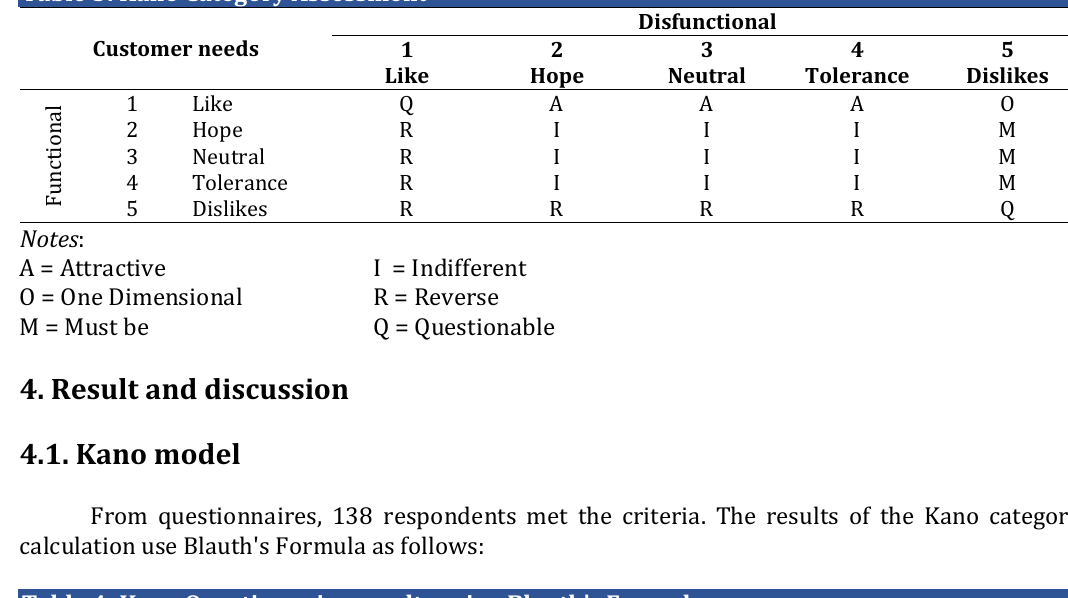
Table 4: Kano Questionnaire results using Blauth’s